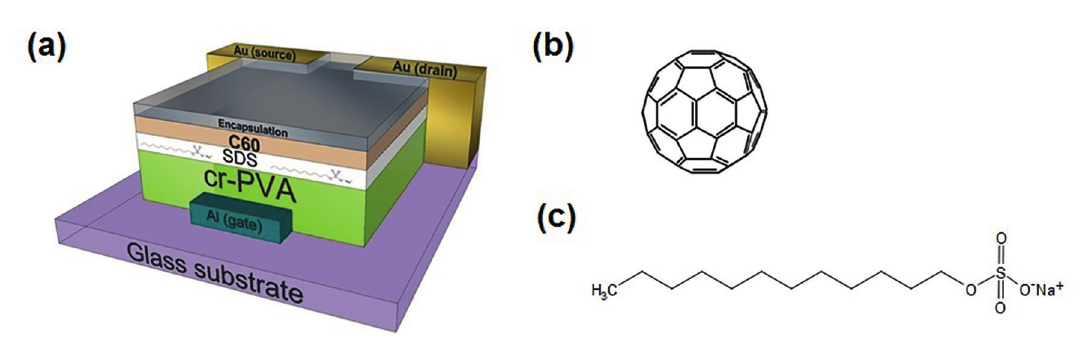
, and; (c) chemical structure of 60